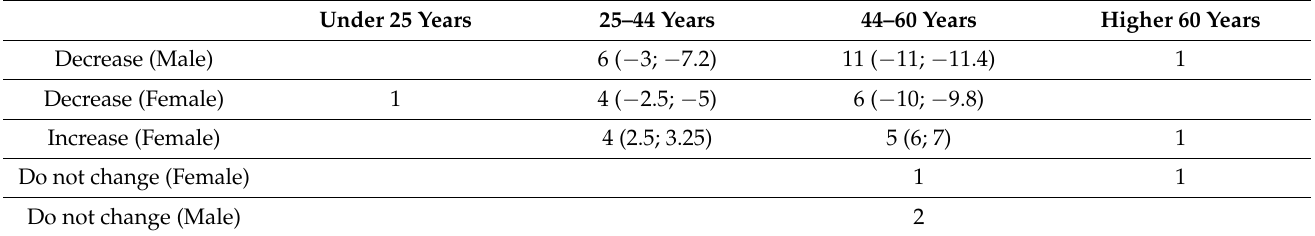
Table 3. Gender Group